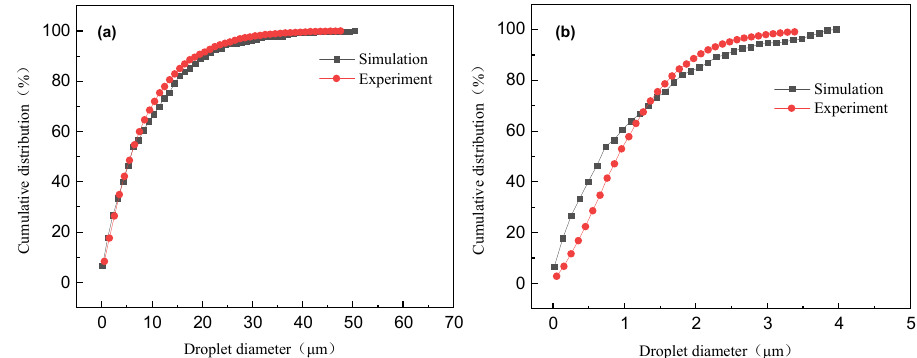
Figure 3. Comparison of droplet diameter distribution between experiment and simulation. ( a ) Droplet diameter distribution of spray 5 mm away from the nozzle exit; ( b ) Droplet diameter distribution of spray 80 mm away from the nozzle exit.